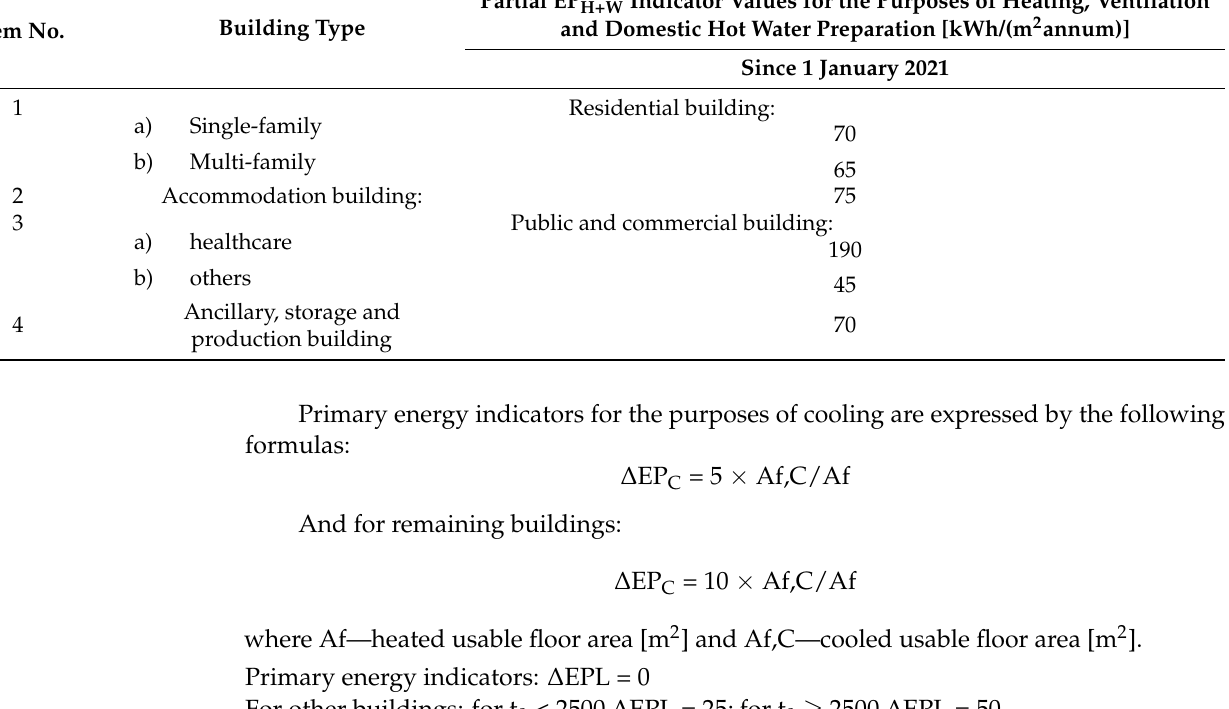
Table 2. Partial primary energy (EP) coefficient values for the purposes of heating, ventilation and domestic hot water preparation.